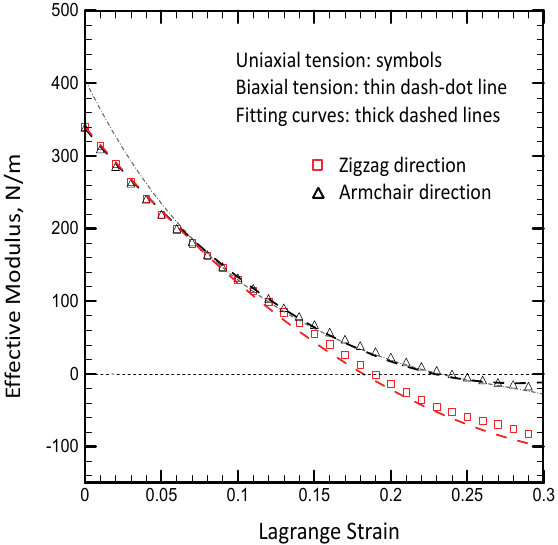
Figure 4. Effective modulus of graphene ( E ') determined under uniaxial/biaxial tension with different Lagrange strain. The dashed lines are the fitting curves as Equation: 2 2